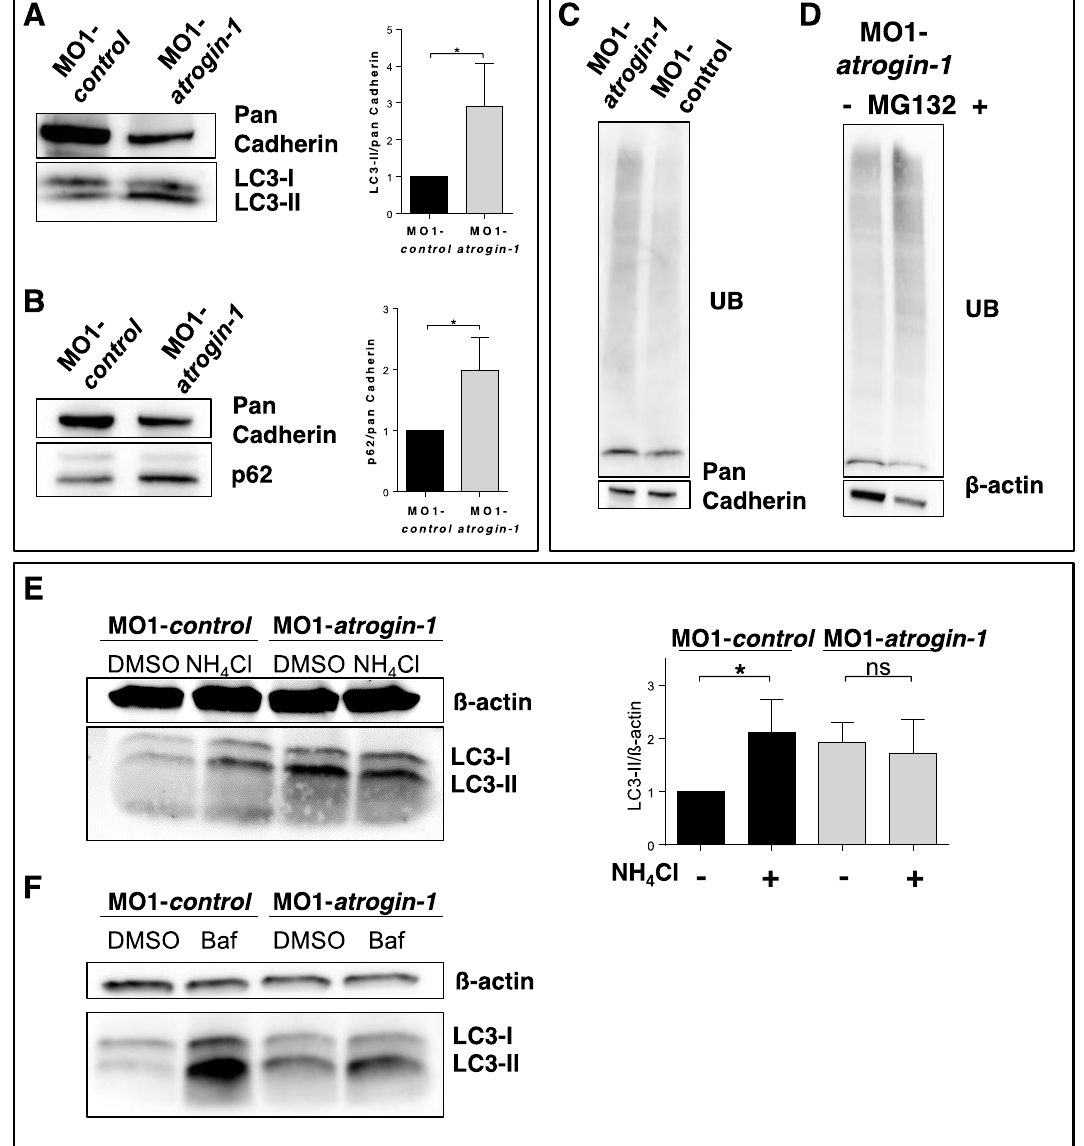
Figure 5. Atrogin-1 deficiency results in an accumulation of p62 and LC3-II and blocks autophagy. ( A , B ) Representative Western Blots of protein levels of the autophagy markers LC3 ( A ) and p62 ( B ) in MO1- control and MO1- atrogin-1 injected embryos. Gray values were measured, quantified and data statistically evaluated (data represent means ± SD, student´s t -test, * p < 0.05) ( A , B ); ( C , D ) Western Blotting of ubiquitinated proteins in protein lysates of control injected embryos compared to Atrogin-1-deficient embryos ( C ) and Atrogin-1 morphants with or without treatment with the UPS inhibitor MG132 ( D ); ( E ) Western Blot analysis of MO1 -control and MO1- atrogin-1 injected embryos, DMSO or NH 4 Cl incubated for 12 h. Significant increase in MO1- control treated embryos compared to DMSO control, whereas no alteration was observed in MO1- atrogin-1 morphants, data represent means ± SD, student´s t -test, * p < 0.05, ns = not significant; ( F ) Western Blot analysis of Bafilomycin A1 treated embryos.